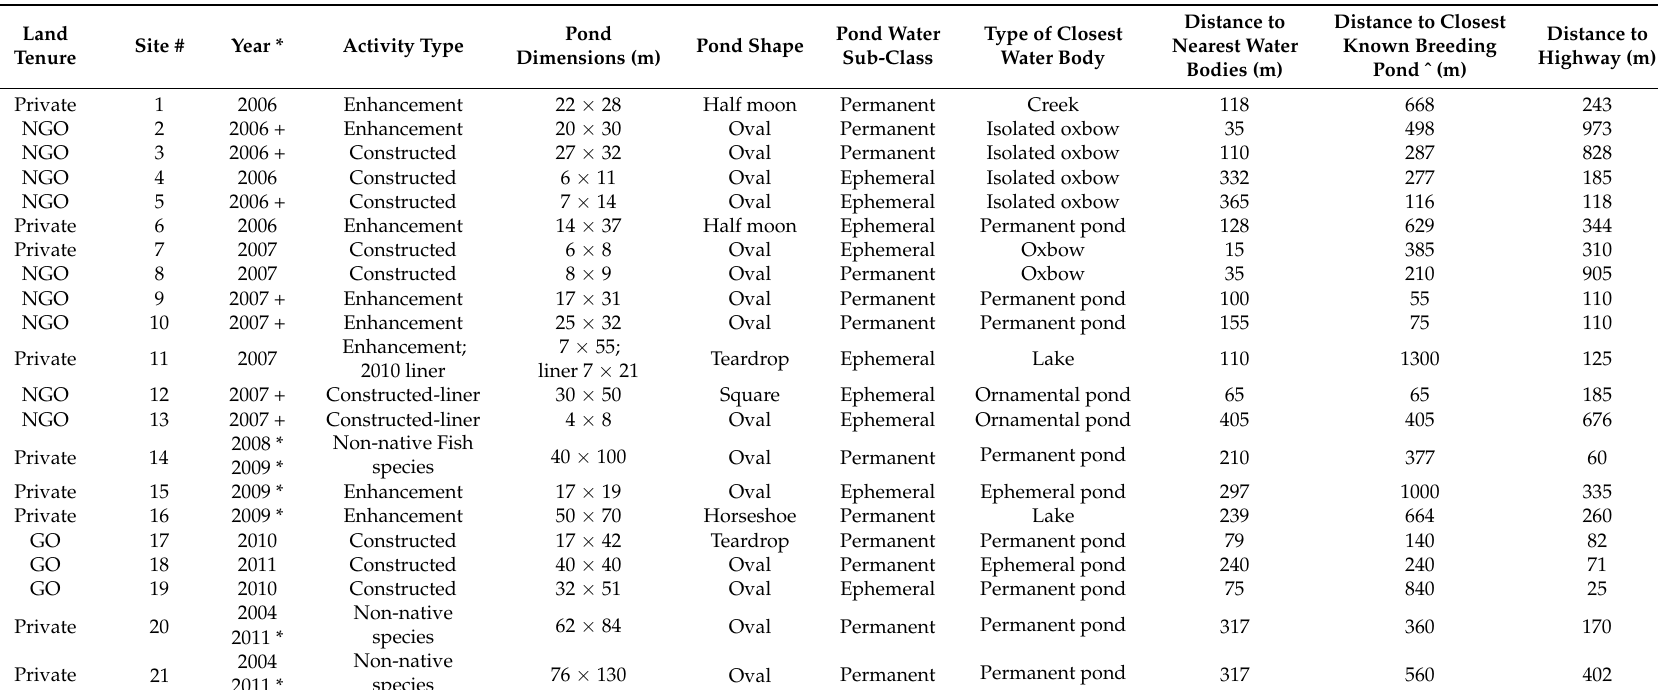
Table 1. Summary of pond enhancement and construction site activities, general pond parameters, and site selection criterion, south Okanagan River Valley British Columbia, 2006–2012. Codes: NGO Non-governmental organization, GO Governmental